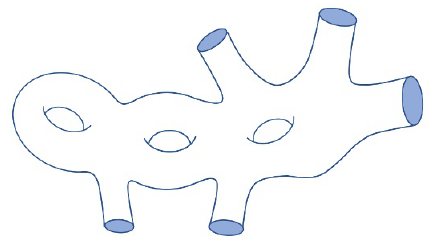
Figure 13 . A genus-3 Riemann surface with (cid:12)ve